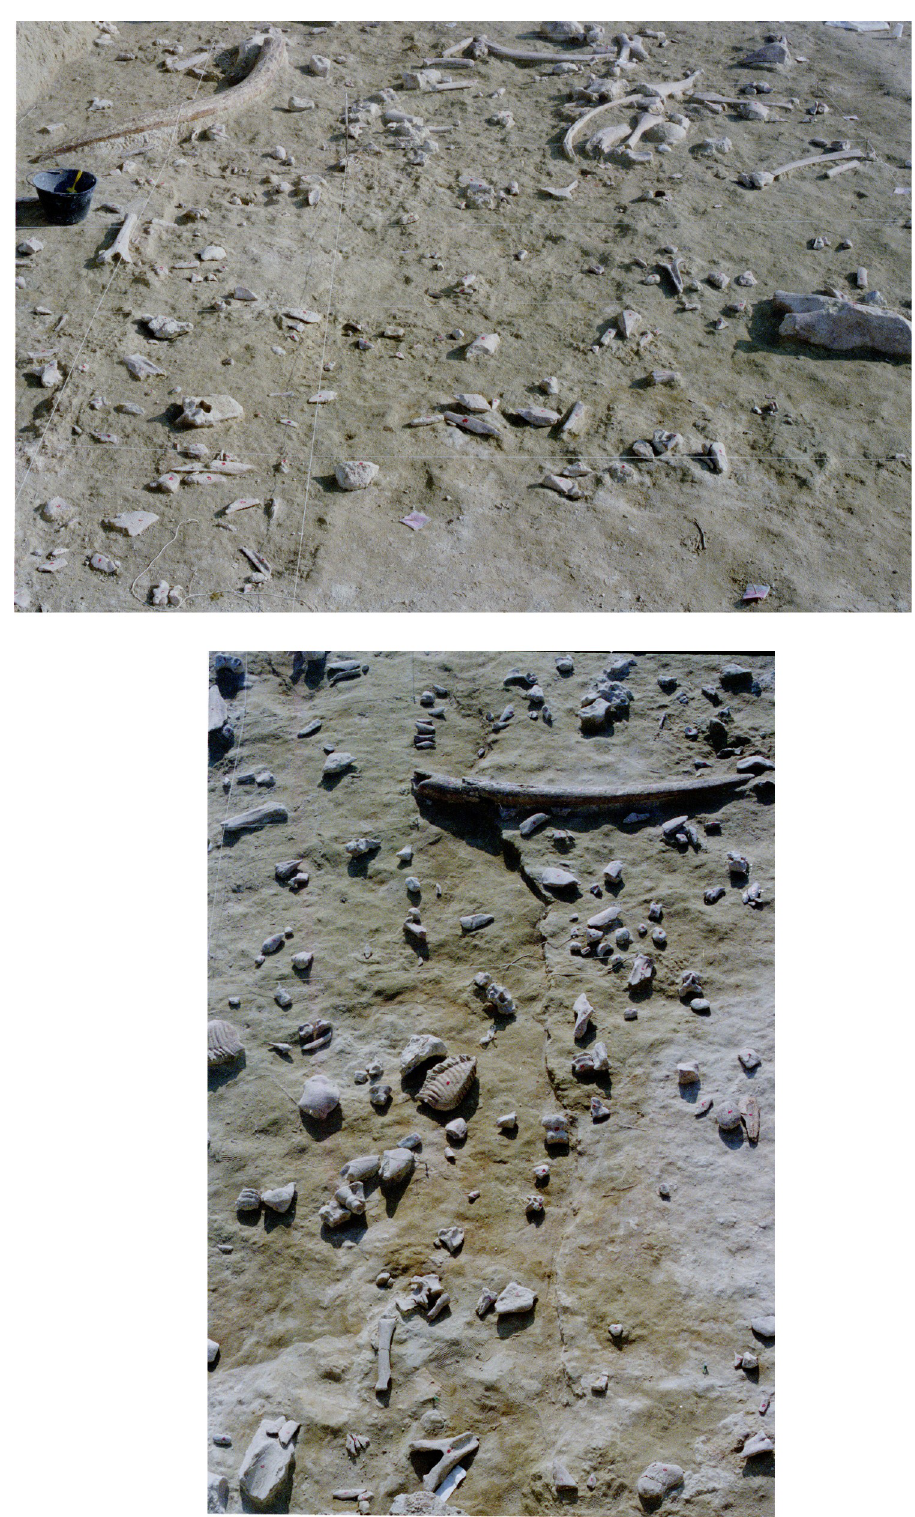
Fig 5. CdG excavation photo. Dispersed elements. The microfault (bottom image) is probably due to postdepositional sediment pressure or a small earthquake.